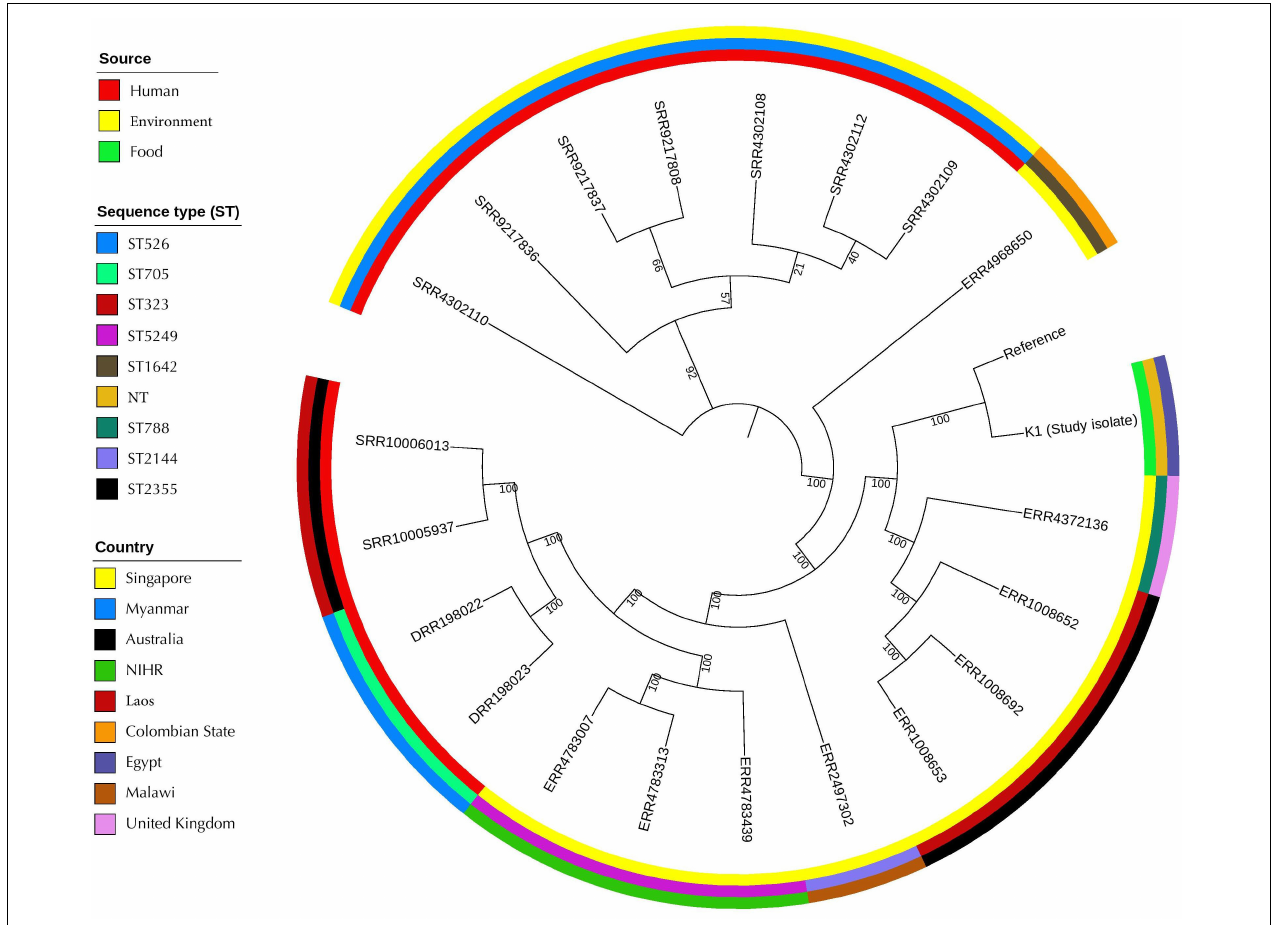
FIGURE 4 | Global phylogenomic analysis of the present study K. pneumoniae isolate (K1) and the publicly available genomes of mcr- 10-producing K. pneumoniae ( n = 20) in the NCBI database. Isolates were mapped to a reference K. pneumoniae complete genome 30684/NJST258_2